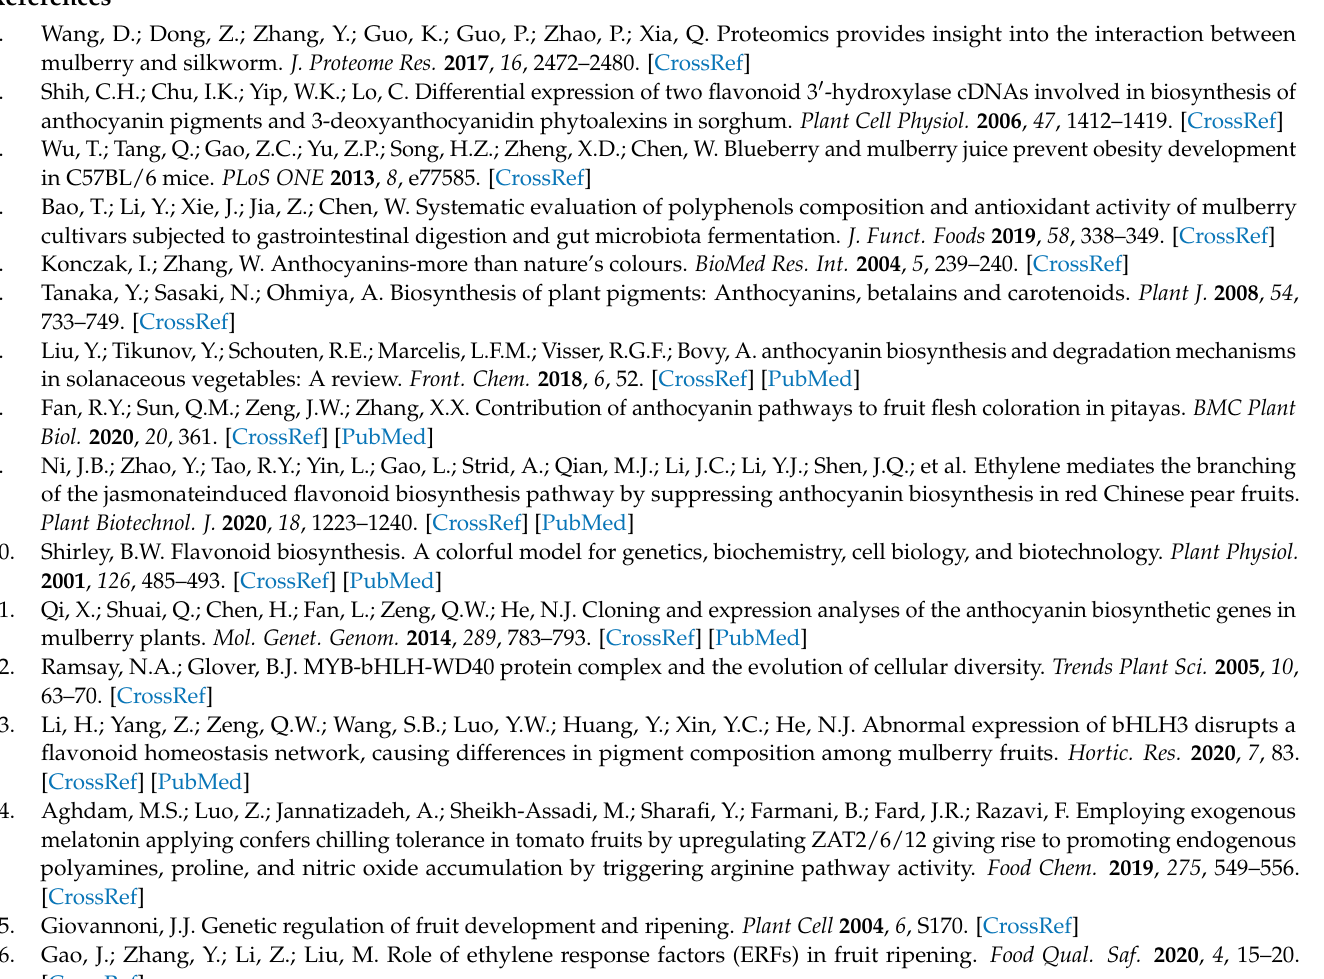
stages; Figure S7: Pearson correlation coefficient, PCC ( r ) between the anthocyanin content and the expressions of the ERF gene family in ZJ and ZZB at different development